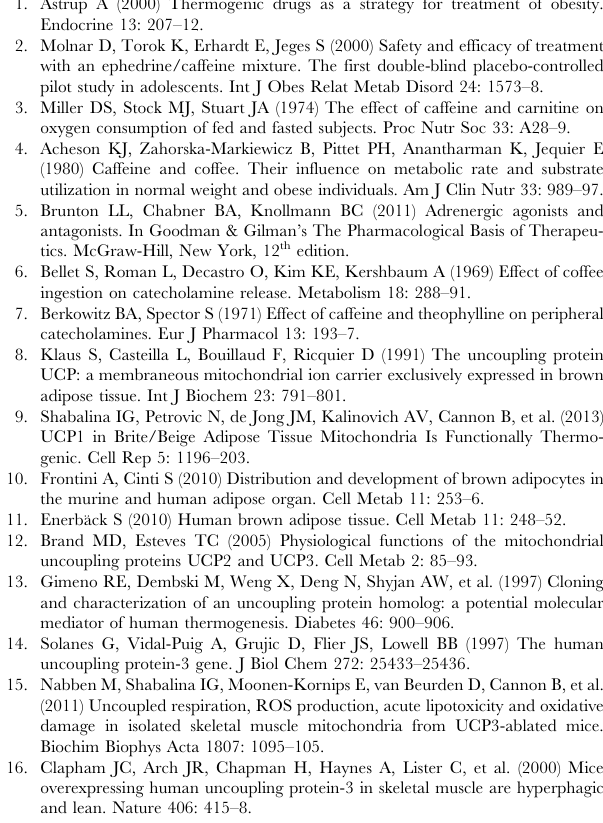
Protocol S1 Trial Protocol. Evaluation of diet and treatment with a combination of ephedrine and caffeine on thermogenesis, cardiac function and on uncoupling proteins expression in adipose and muscle tissue of morbid obese patients undergoing bariatric